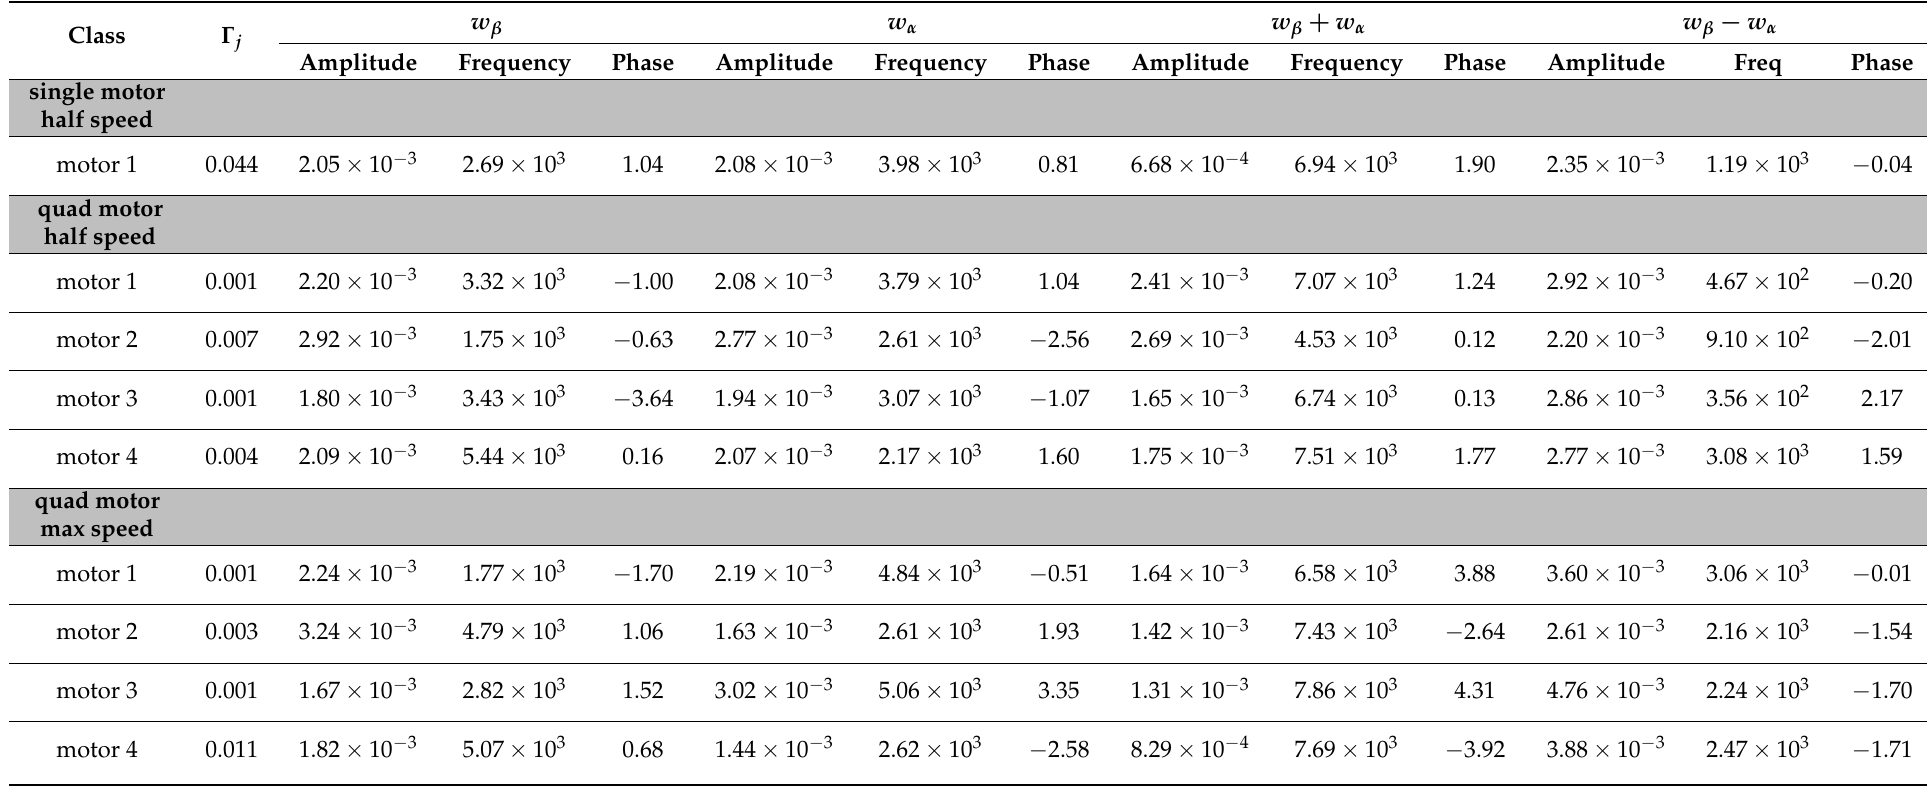
Table 1. Micro-Doppler model coefficients for different UAV state